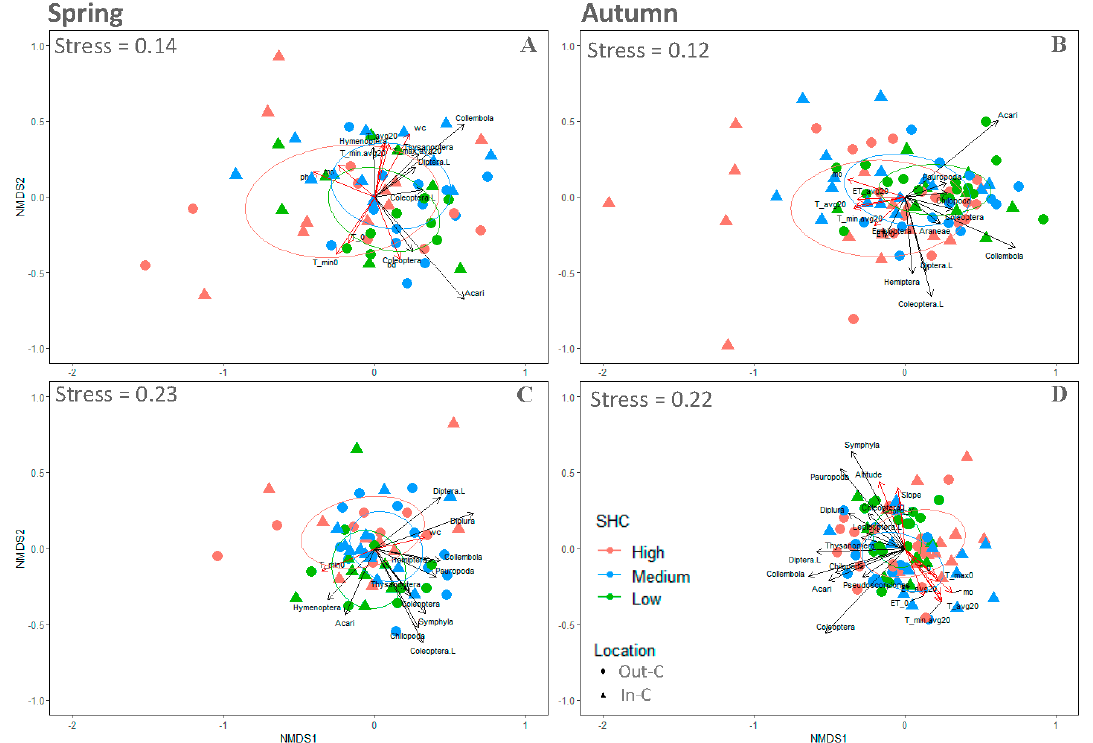
Figure 4. Community composition fits categorical predictors (SHC and location factor), environmental parameters and taxa (abundances and EMIs). Log-transformed abundance matrices for spring and autumn samplings are shown in graphics ( A ) and ( B ), respectively; EMI-values matrices for spring and autumn samplings are shown in panels ( C ) and ( D ), respectively. Black arrows show the fitting of significant taxa, whereas red arrows show the fitting of significant environmental variables. Location indicates whether the sampling point was established beneath the tree canopy or outside the canopy; SHC indicates the characteristics of the surrounding environment, as well as the pressure of the livestock where sampling points were placed; bd = bulk density; ET_avg20 = average evapotranspiration of the 20 days prior to sampling; mo = soil organic matter content; T_0 = mean temperature of the sampling day; T_avg20 = average temperature of the 20 days prior to sampling; T_max0 = maximum temperature of the sampling day; T_min0 = minimum temperatures of the sampling day; T_min.avg20 = average minimum temperature of the 20 days prior to sampling; wc = soil water content.